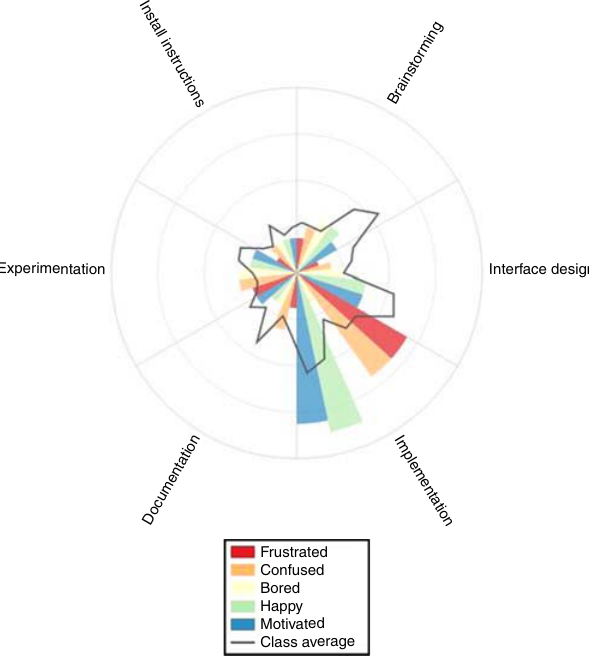
Source: Polar bars show the values for the active student, while the solid line shows the class average. Sedrakyan et al. (2017) (used with permission)